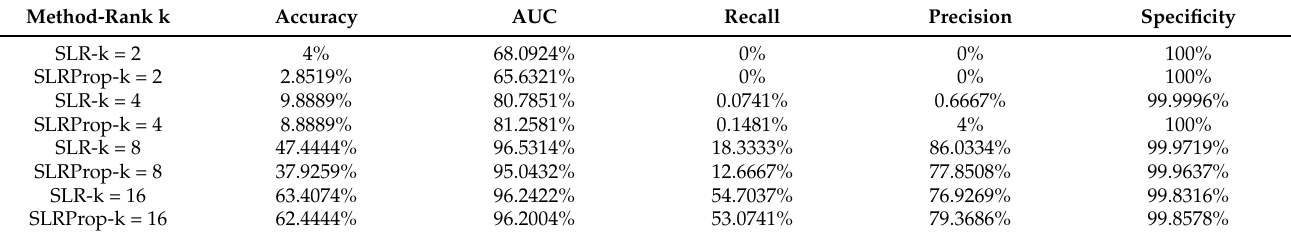
Table A2. SLR vs. SLRProp Cifar100.